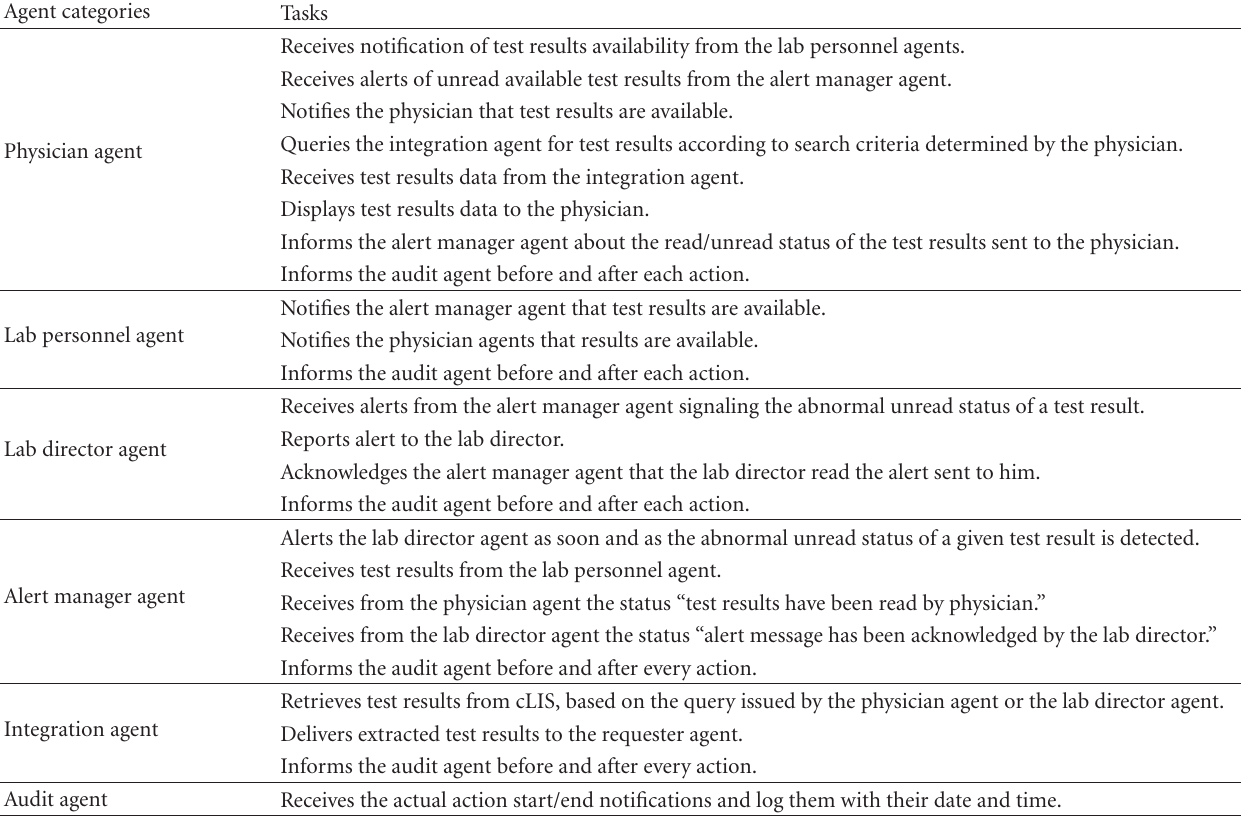
Table 2: Tasks performed by agent